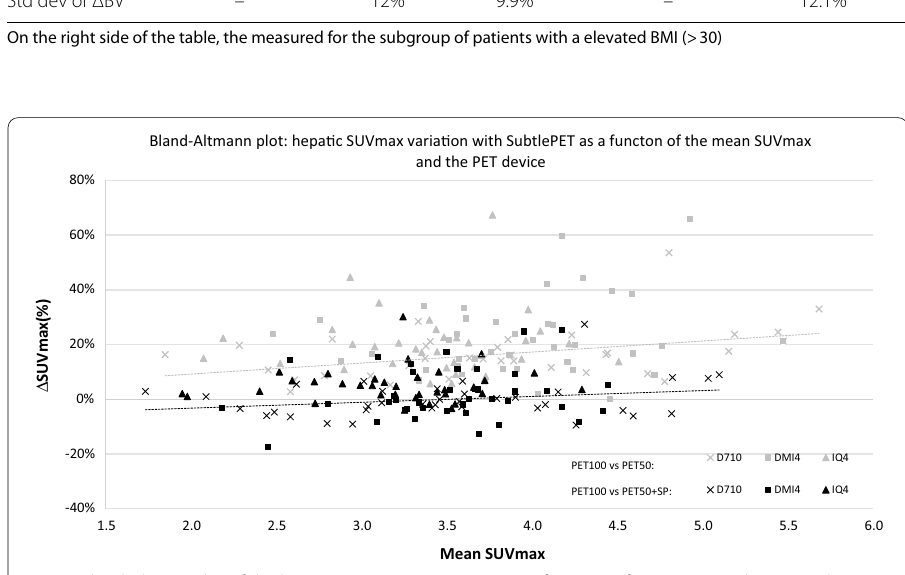
On the right side of the table, the measured for the subgroup of patients with a elevated BMI (> 30)